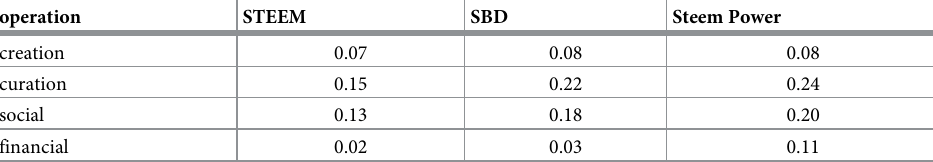
Table 4. User reward hubs. Correlation of currency and